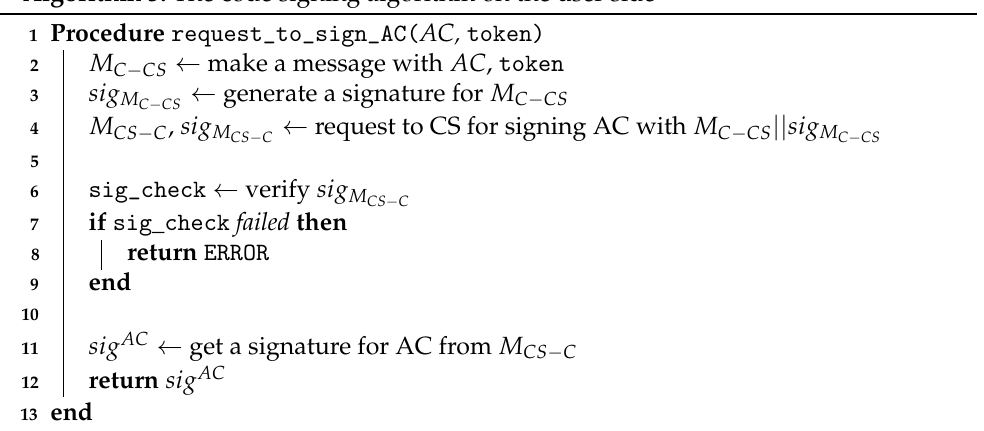
Algorithm 3: The code signing algorithm on the user